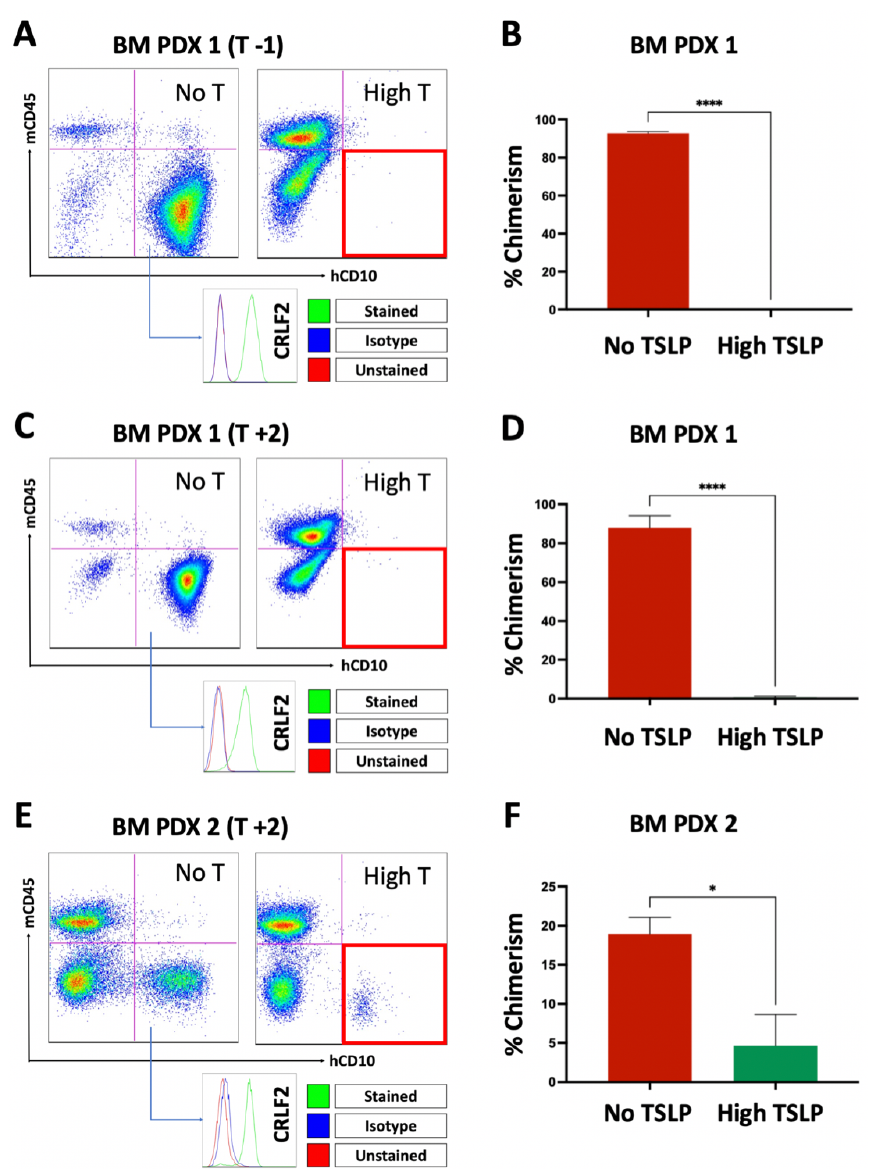
Figure 4. High TSLP doses dramatically reduced CRLF2 B-ALL cell engraftment in PDXs. CRLF2 B-ALL cells from patient-1 and patient-2 were used to establish PDX-1 and PDX-2 xenografts, re- spectively. Weekly stromal-cell injections to produce no-TSLP (No-T) or high-TSLP (High-T) PDXs commenced one week before transplant (T -1) or 2 weeks after transplant (T +2). Bone marrow (BM) was harvested for flow cytometry analysis to detect human CRLF2 B-ALL cells (hCD10 +/mCD45 -). ( A ) Representative dot plot for PDX-1 (T -1) BM showing less engraftment (right lower red quadrant) in High-T mice compared to No-T mice. ( B ) Bar graph comparing the percent of human leukemia cells in the mouse bone marrow (chimerism) between No-T and High-T groups for PDX-1 (T -1). ( C ) Representative dot plot for PDX-1 (T +2) BM showing less engraftment (right lower red quadrant) in High-T mice compared to No-T mice. ( D ) Bar graph comparing percent chimerism between No-T and High-T groups for PDX-1 (T +2). ( E ) Representative dot plot for PDX-2 (T +2) BM showing less engraftment (right lower red quadrant) in High-T mice compared to No-T mice. ( F ) Bar graph comparing percent chimerism between No-T and High-T groups for PDX-2 (T +2). Graphs generated from ≥ 4 No-T and ≥ 4 High-T PDXs. * p < 0.05, **** p <